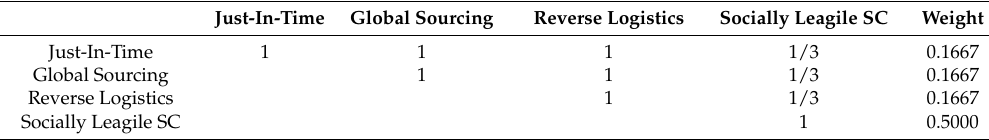
Table A15. Pairwise Comparison of Alternative w.r.t. sub-criterion Medical